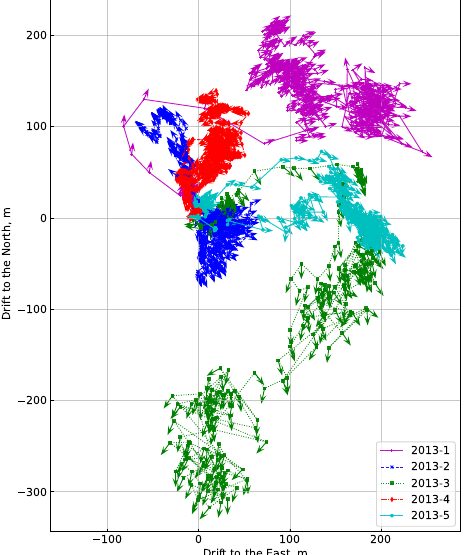
Figure 4. The SPHERE-2 detector drift in 2013. The arrows indicate the detector magnetometer orientation. The start point is located at zero coordinates. The points indicate detector position in 1 min